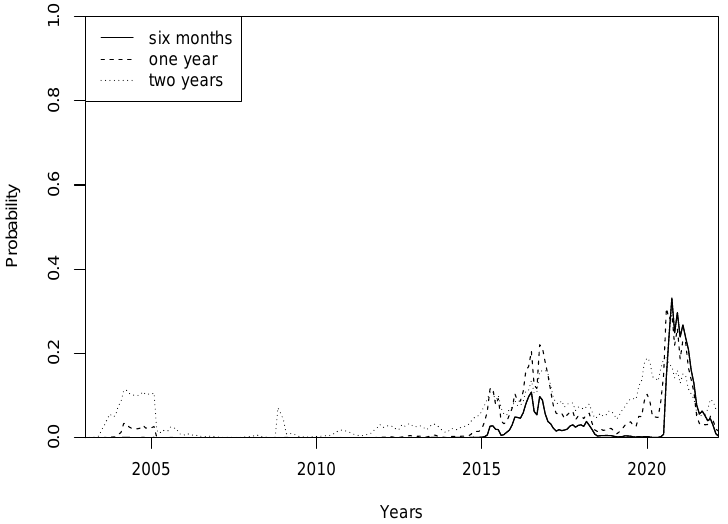
Figure 5. Probability of negative rates. JSZ-implied real-world P probabilities of negative future short-term interest rates at horizons of 6 months, 1 year, and 2 years. Sample period: 2001/04 to